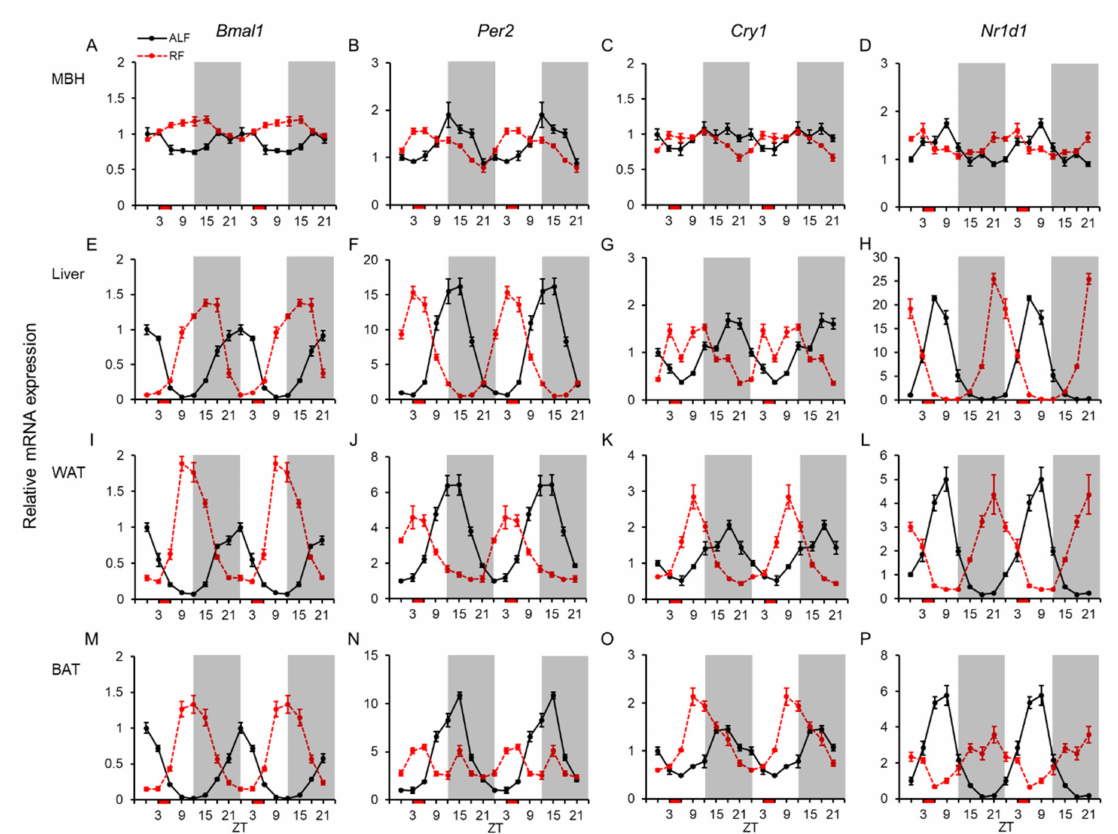
Figure 1. mRNA expression levels of clock genes in the central and peripheral tissues. Double-plotted graphs showing the mRNA expression levels of the brain and muscle ARNT-like 1 ( Bmal1 ), period 2 ( Per2 ), cryptochrome 1 ( Cry1 ), and nuclear receptor subfamily 1 group D member 1 ( Nr1d1 ) genes in the mediobasal hypothalamus (MBH: A – D ), liver ( E – H ), white adipose tissue (WAT: I – L ), and brown adipose tissue (BAT: M – P ) under ad libitum feeding (ALF: Black lines) and time-restricted feeding (RF: Red lines) schedules. Data are expressed as the mean ± standard error of the mean, n = 5–6 mice per datum